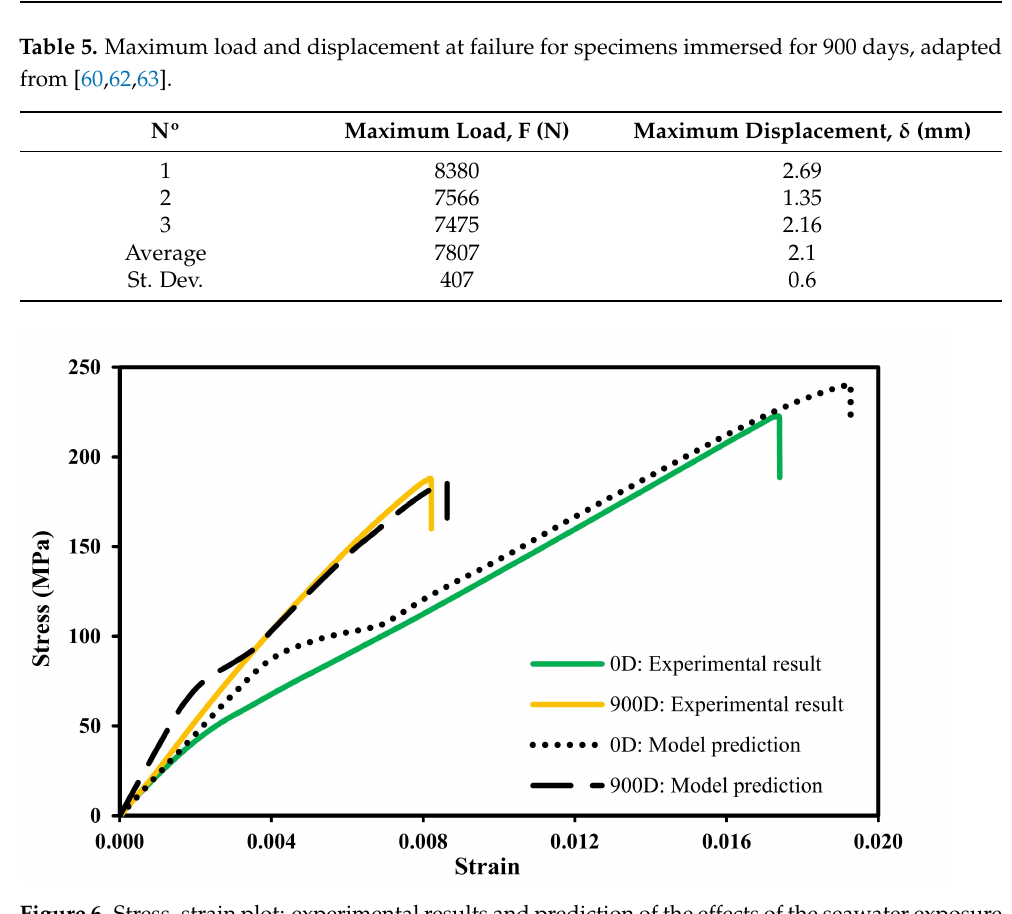
Figure 6. Stress–strain plot: experimental results and prediction of the effects of the seawater exposure for 0 and 900 immersion